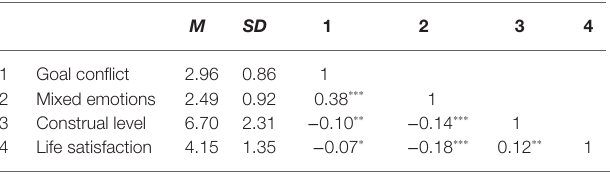
TABLE 1 | Descriptive statistics and correlation matrix of all